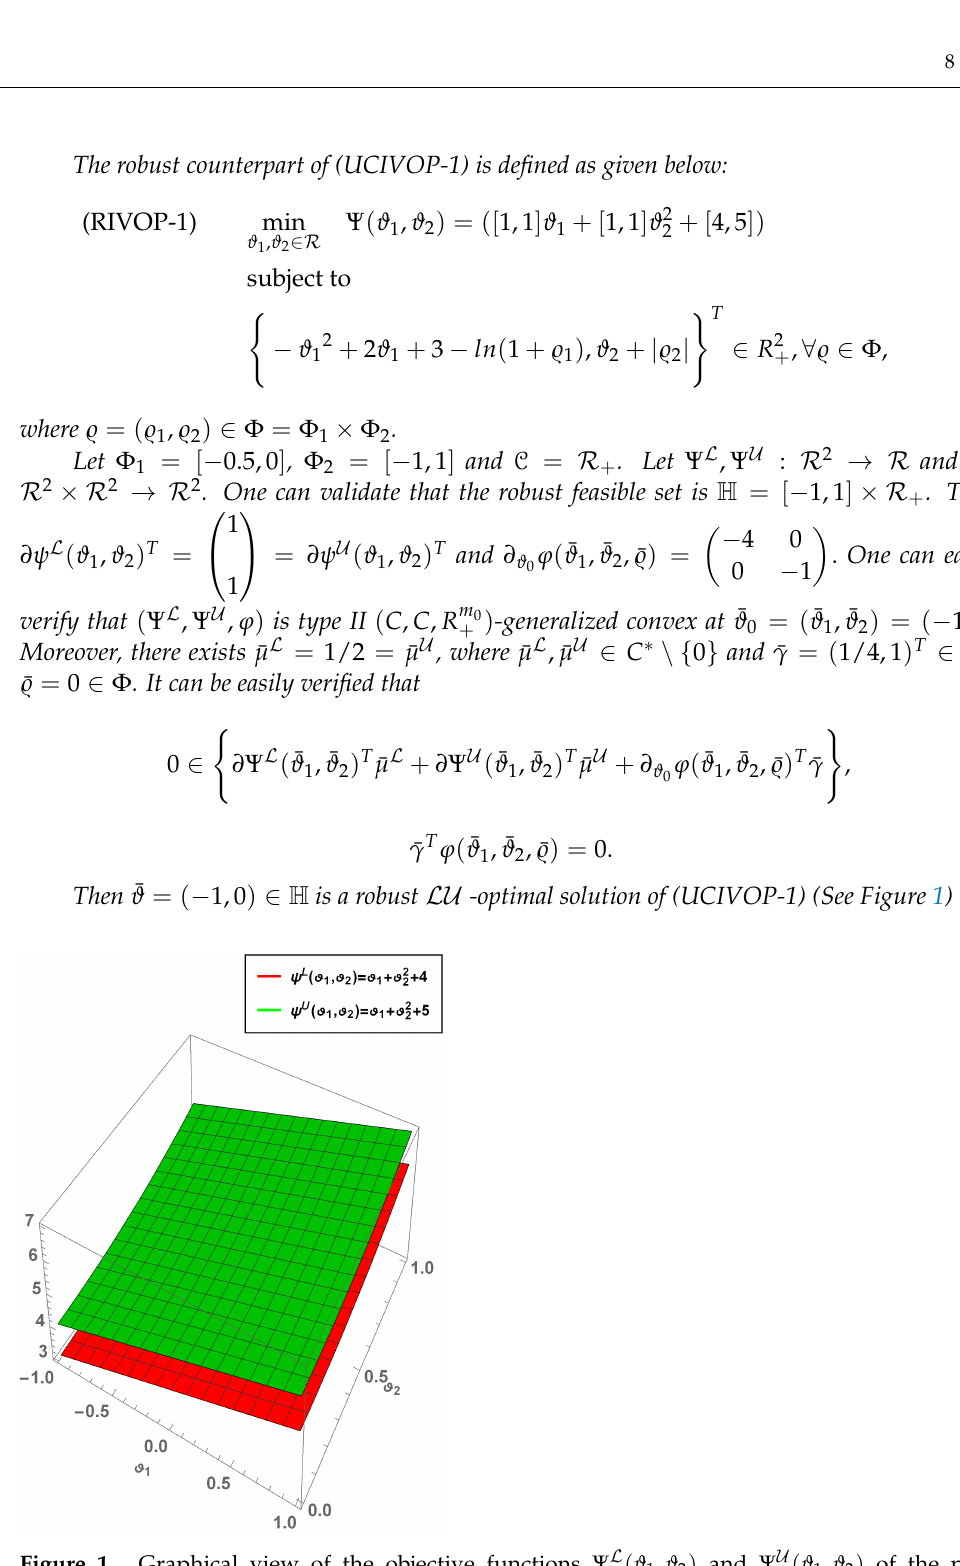
Figure 1. Graphical view of the objective functions Ψ L ( ϑ 1 , ϑ 2 ) and Ψ U ( ϑ 1 , ϑ 2 ) of the prob- lem